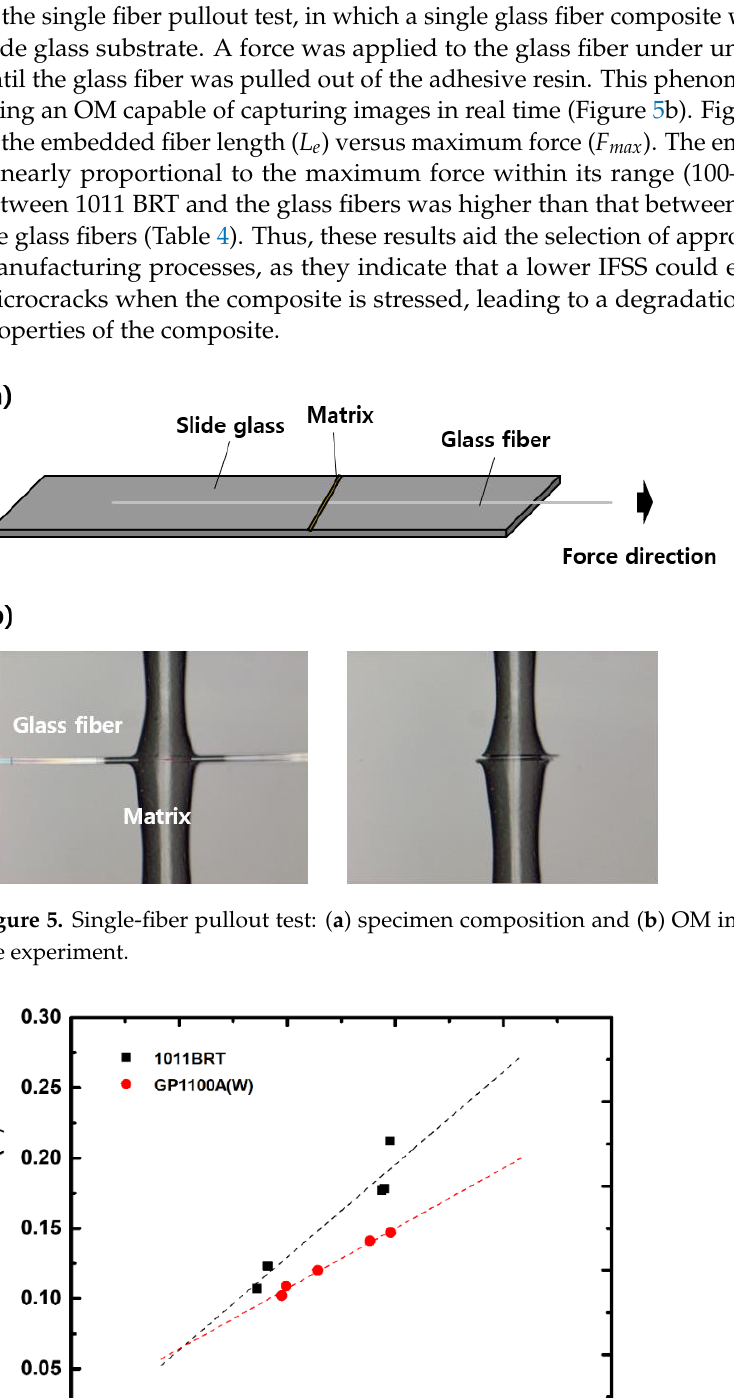
Figure 4. Results of rotational rheometer tests for PA6 resin: ( a ) 1011 BRT and ( b ) GP 1100A (W).